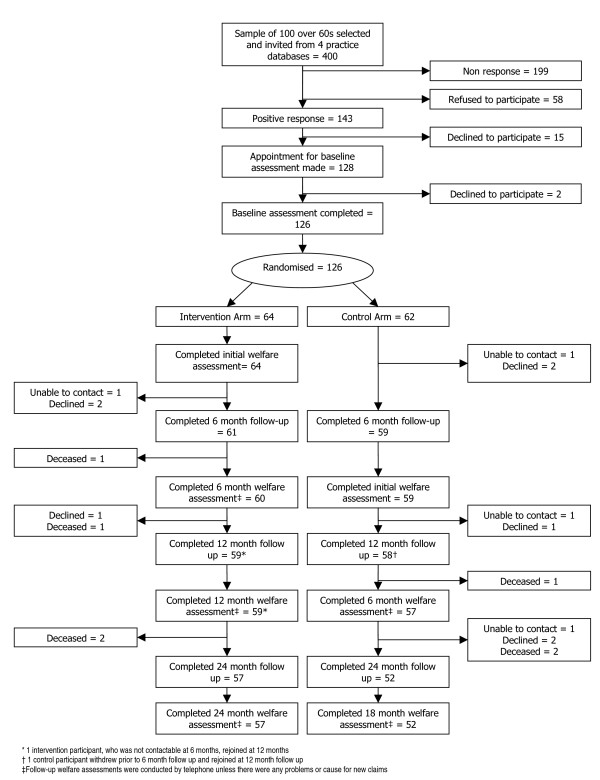
Participant flow and follow-up.